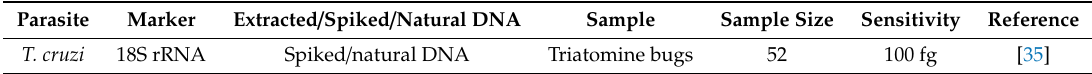
Table 2. Publications found in the US National Library of Medicine National Institutes of Health (NCBI-PubMed) reporting the standardisation of the LAMP technique as a useful tool for diagnosing Chagas’ disease (American trypanosomiasis) in the